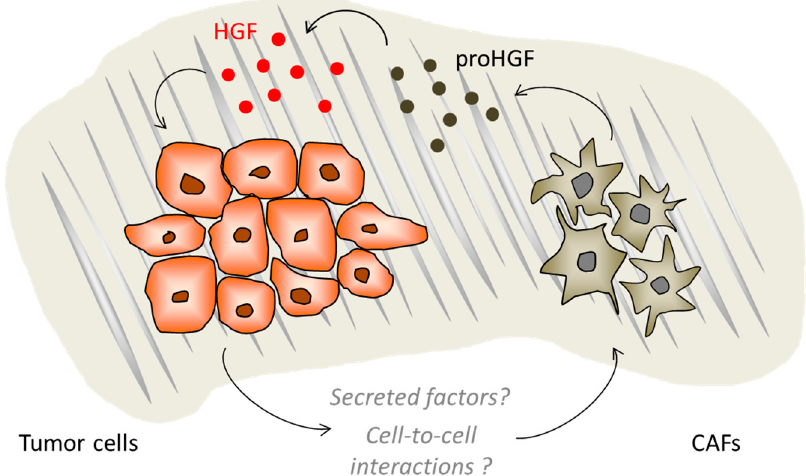
Figure 3. The dynamic bidirectional tumor/stroma interaction. Cancer-associated fibroblasts (CAFs) secrete pro-HGF that is converted in the active mature form by enzymes acting in the tumor microenvironment. Tumor cells can influence CAF activity by mechanisms that have not yet been completely elucidated. The fibrotic components of the extracellular matrix are depicted in grey. The malignant behavior of cancer cells is nurtured by the collateral pro-angiogenic activity of the MET/HGF axis in endothelial (ECs) and stromal cells [76]. MET upregulation in ECs is required